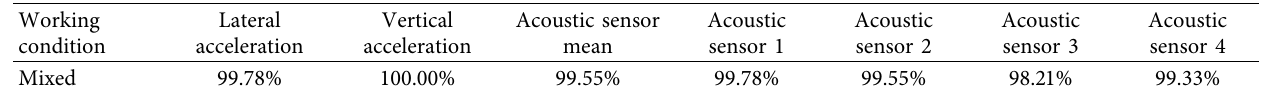
Table 15: Classification accuracy of AVEP data under mixed